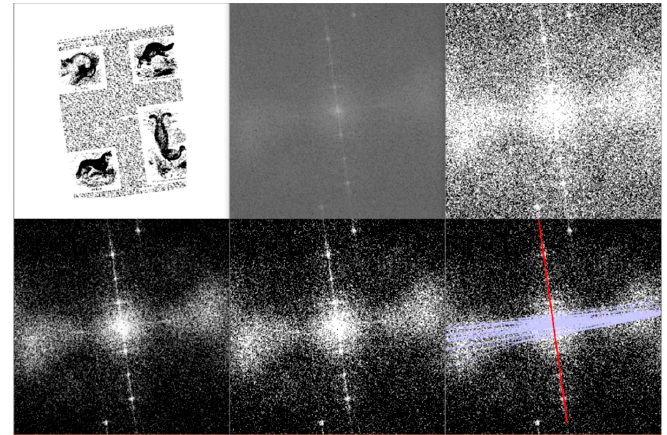
Figure 2. From left to right, top to down: Input, FFT of Input, Otsu on FFT of Input, processed FFT (with contrast stretching and histogram equalization), Otsu on the processed FFT, skew angle detection performed on the latter, using the Hough transform.